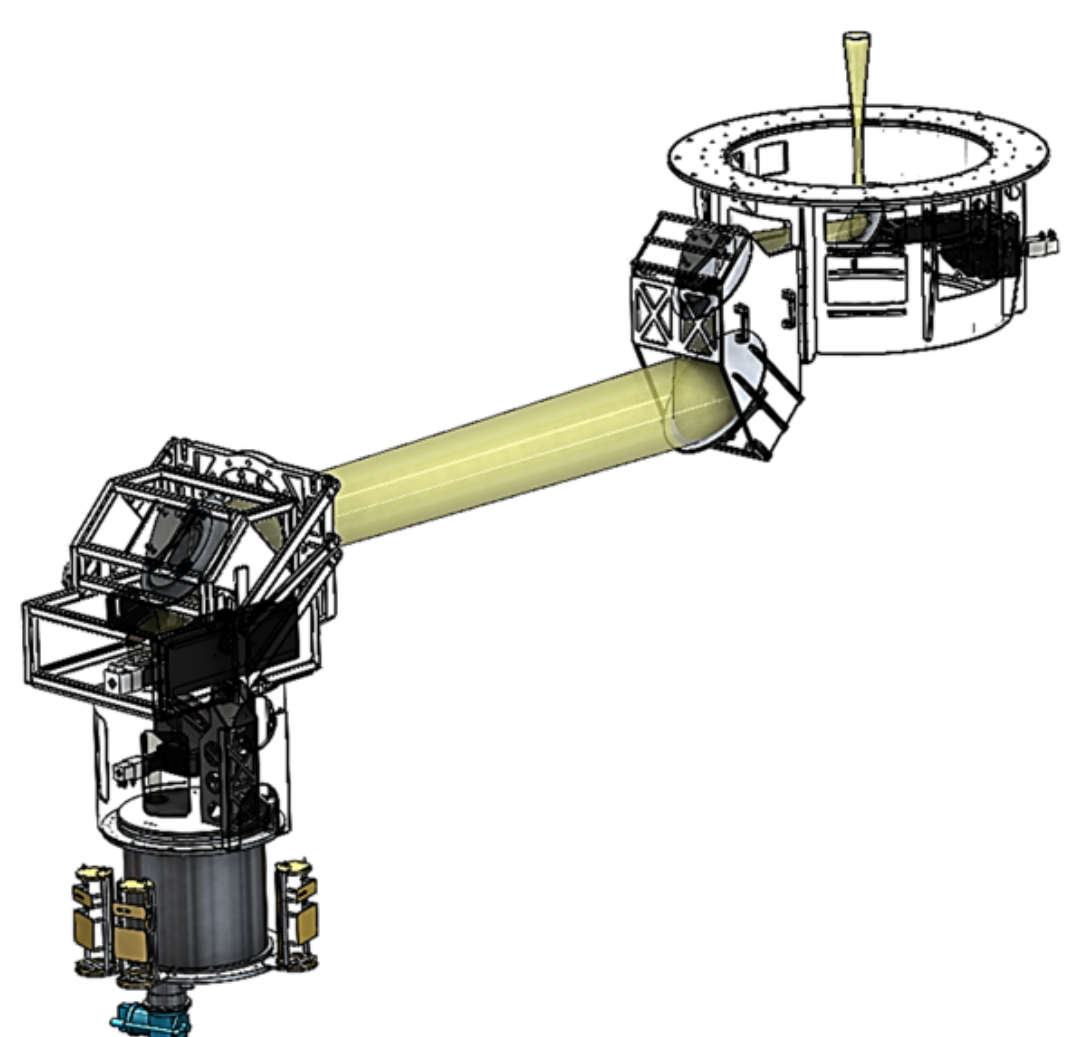
Figure 4. Schematic presentation of the NACOS system. On the right, the CAS system, that goes in the Cassegrain Cabin, just below the dish. The beam, in yellow, can be sent to one Nasmyth cabin or to the other. Here only one of the two NAS systems is presented, on the left side of the figure; it holds a cryostat containing cooled